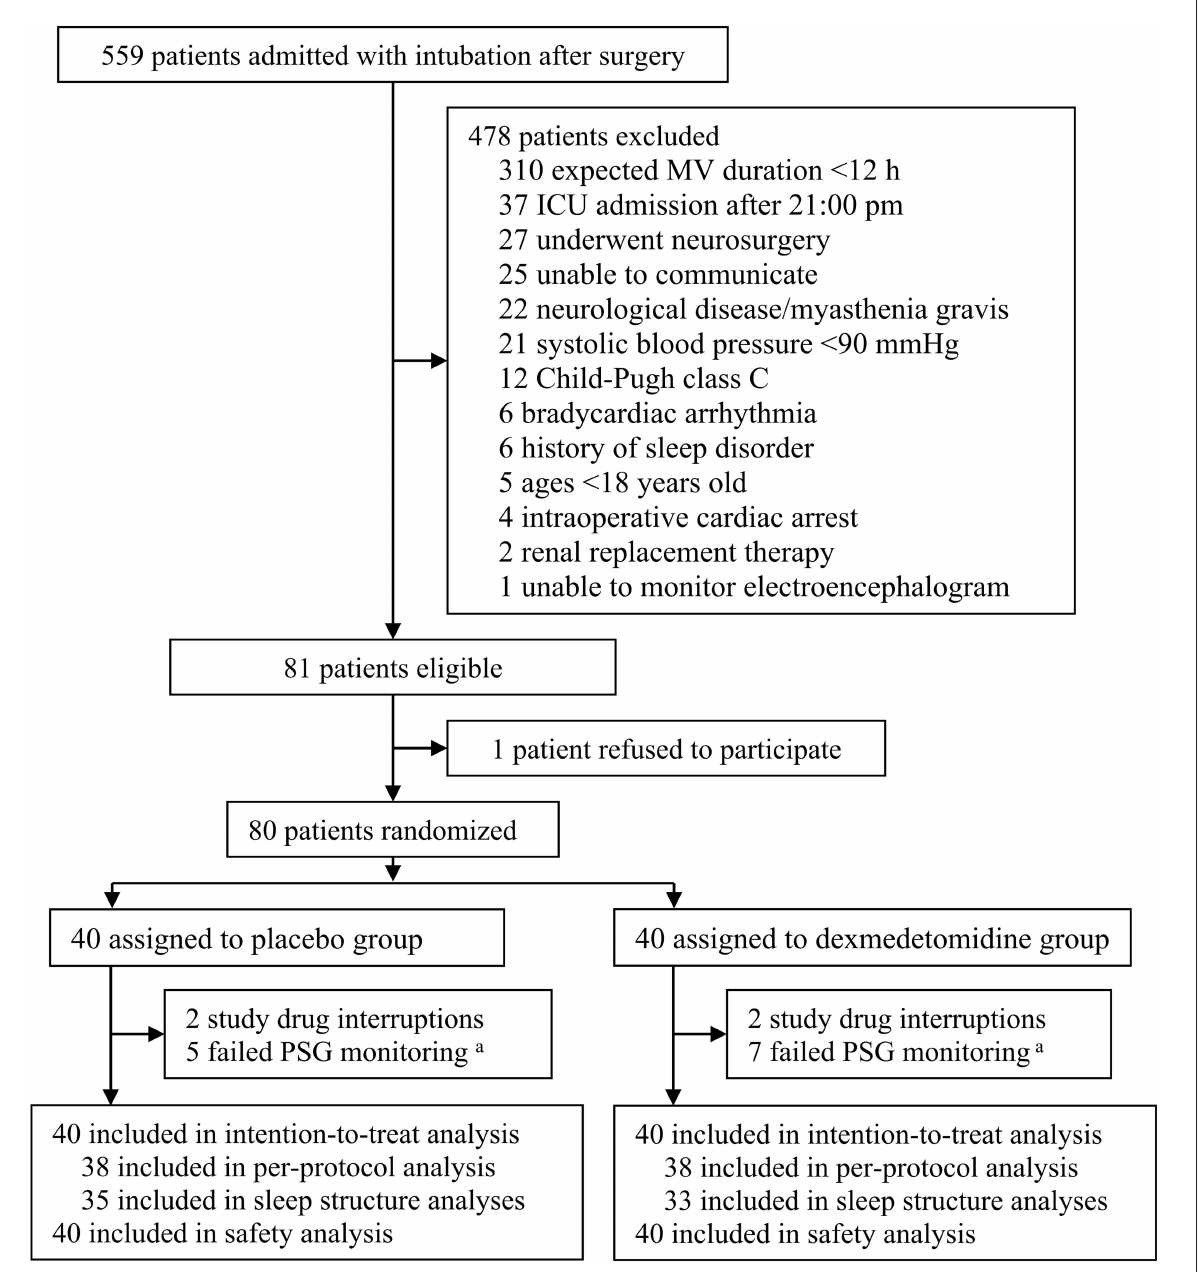
FIGURE1 Flowchart of the trial. MV, mechanical ventilation; ICU, intensive care unit; PSG, polysomnography. a Due to electrode detachment or signal interference.